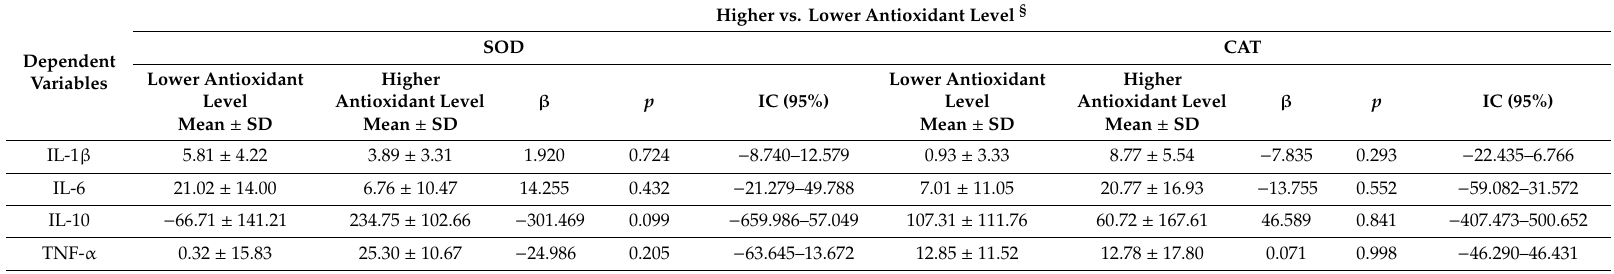
Higher vs. Lower Antioxidant Level